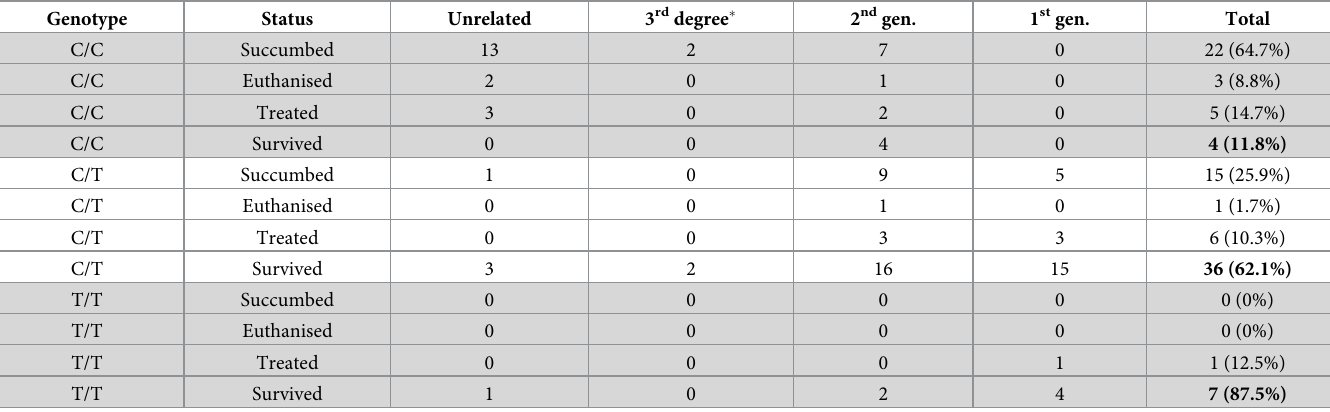
Table 2. The genotype counts of the FAF1B